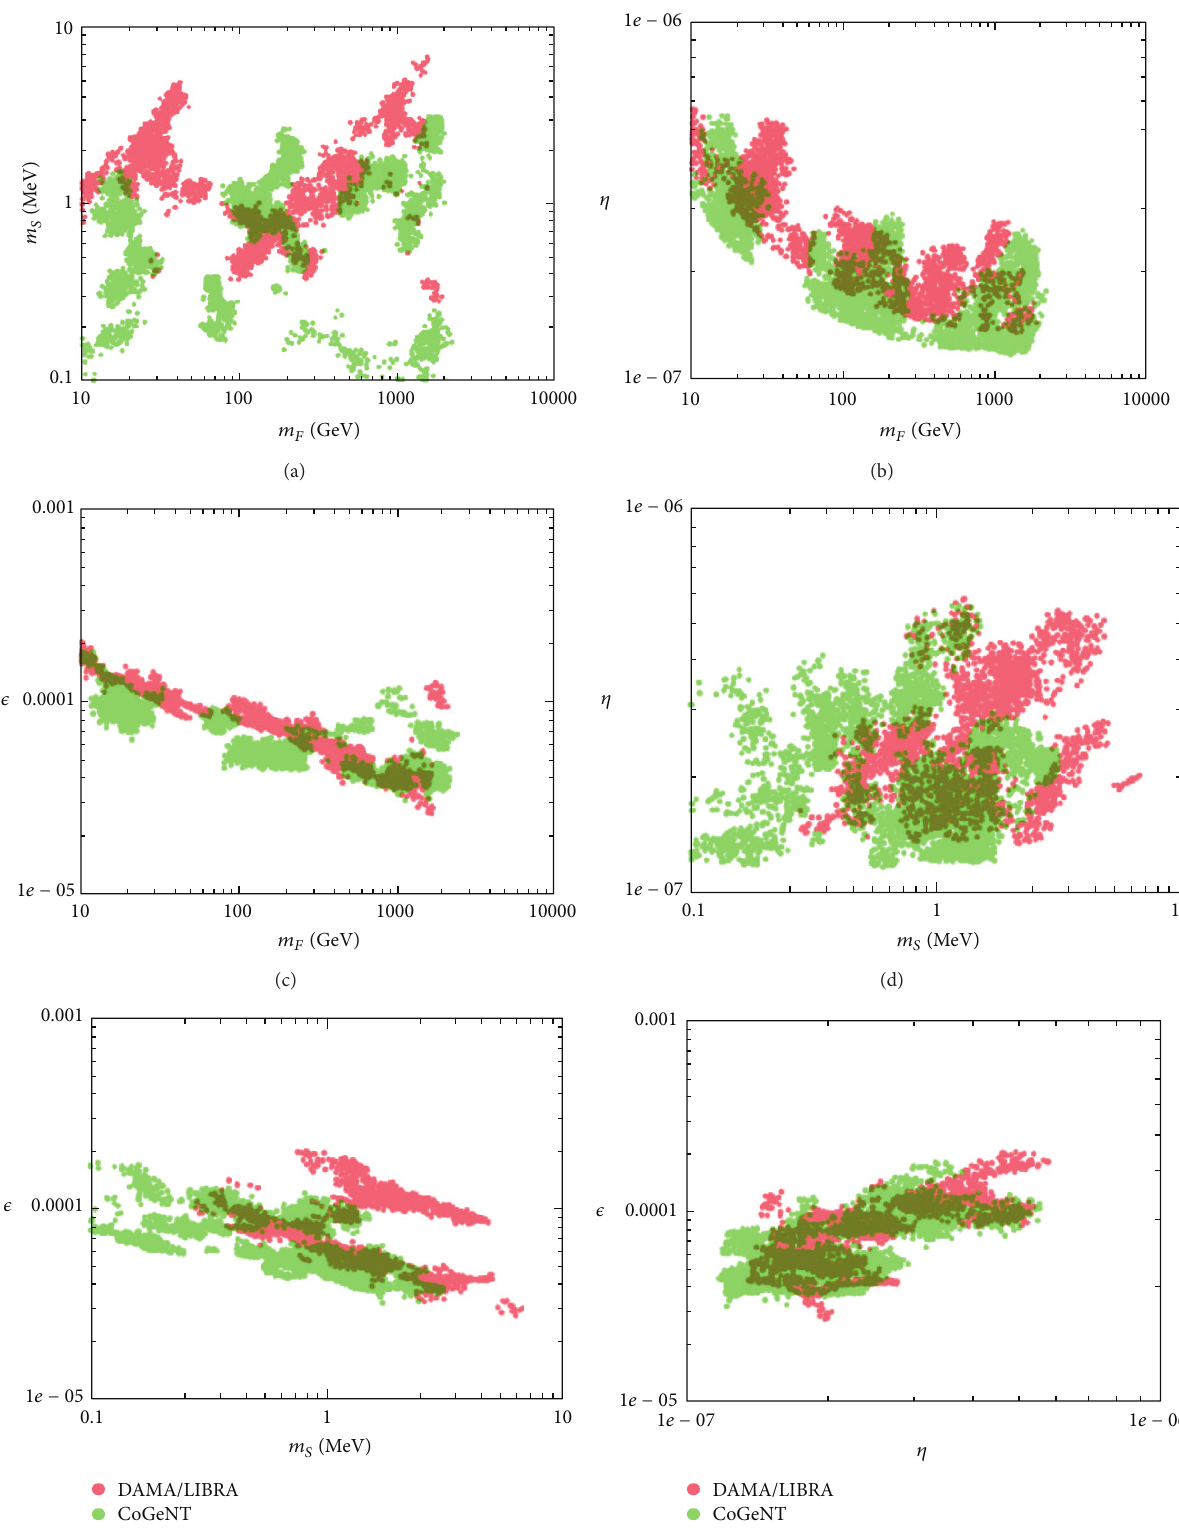
Figure 1: Two-dimensional parameter regions reproducing the DAMA/LIBRA (light red) and CoGeNT (light green) results at the 2𝜎 level. The overlapping regions stand out in dark green. (a) (𝑚 𝐹 ,𝑚 𝑆 ) plane. (b) (𝑚 𝐹 , 𝜂) plane. (c) (𝑚 𝐹 , 𝜖) plane. (d) (𝑚 𝑆 ,𝜂) plane. (e) (𝑚 𝑆 ,𝜖) plane. (f) (𝜂, 𝜖)